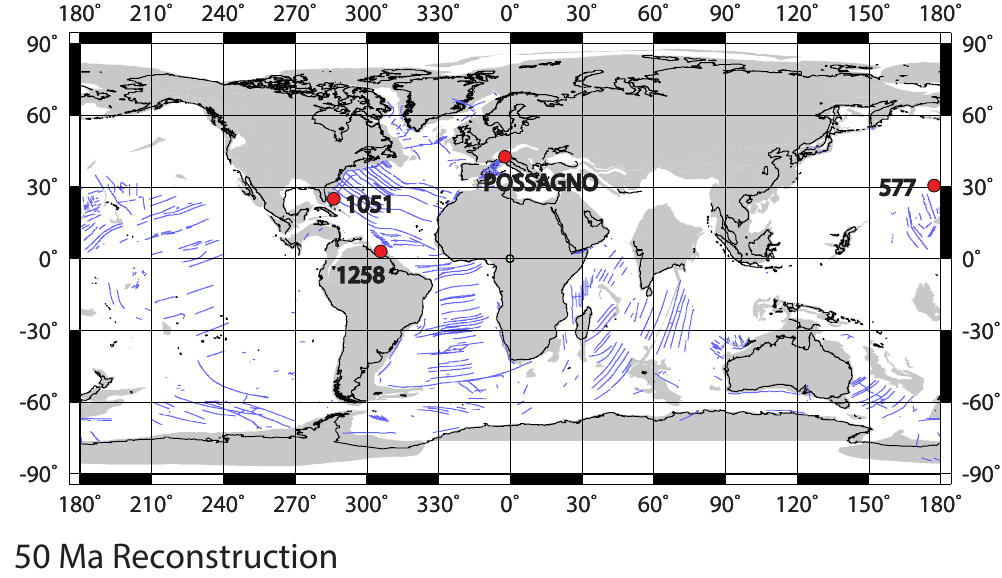
Figure 2. Approximate locations of the three sites discussed in this work during the early Eocene. Also shown is Site 1258, which has a bulk carbonate δ 13 C record spanning the EECO. Base map is from http://www.odsn/de/services/paleomap.html with paleolatitudes modified for Sites 577, 1051 and 1258 according to www.paleolatitude.org model version 1.2 (Van Hinsbergen et al., 2015). Possagno paleolatitude is based on the http://www.odsn.de/odsn/services/paleomap/adv_map.html model since it is not yet available at http://www.odsn/de/services/